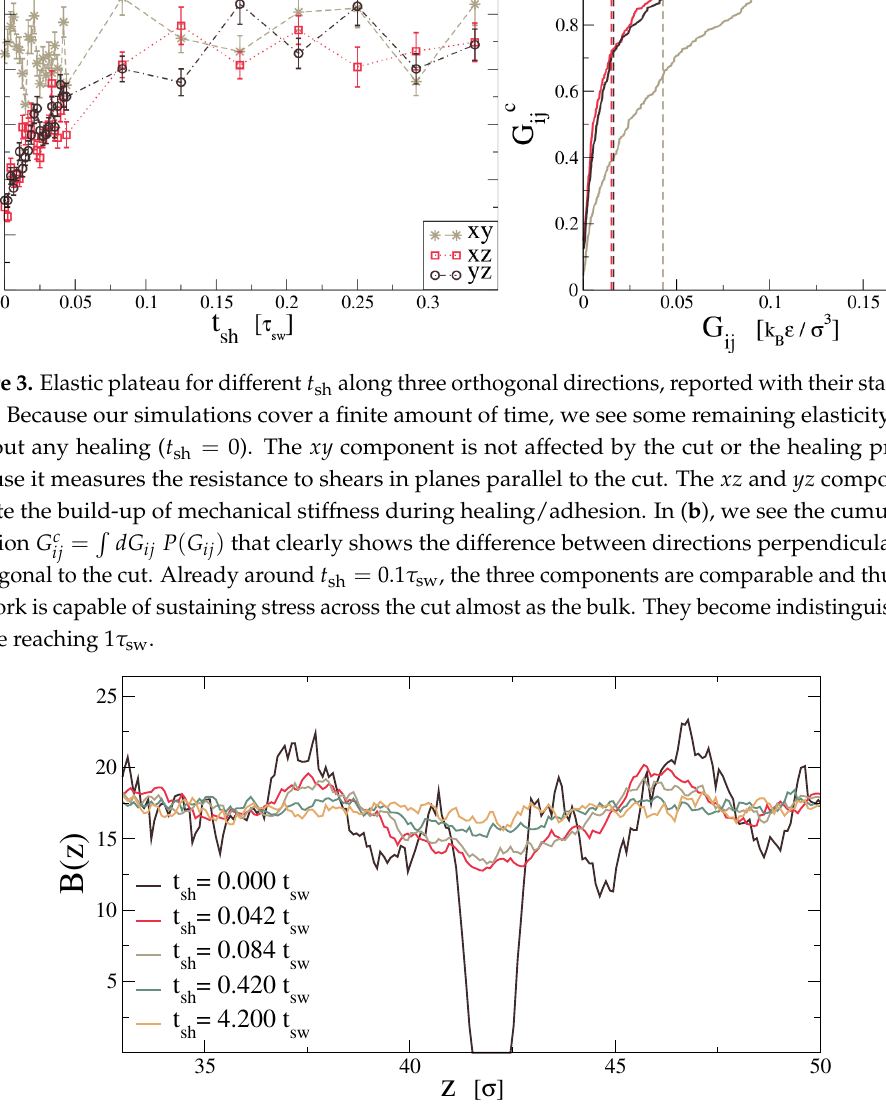
Figure 4. Number of bonds that cut a z -plane for different healing times. At t sh = 0, a layering effect is visible, and we can distinguish three high density layers propagating from the cut. After a progressive healing process, the profile becomes